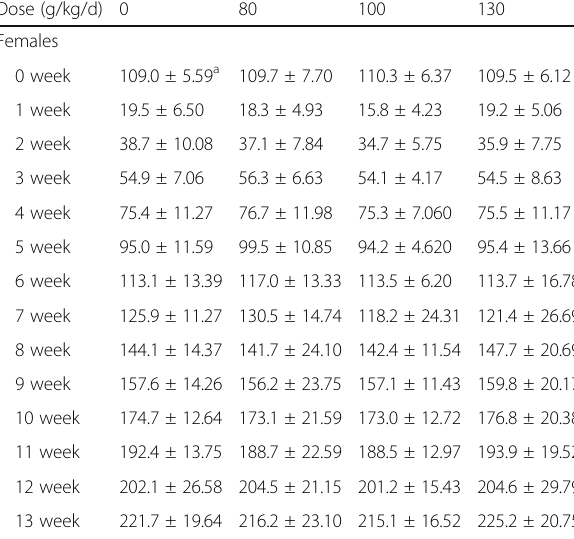
All samples were collected from five rats in each group a Data are given as mean ± SD ANOVA analysis indicated no statistical significance P >